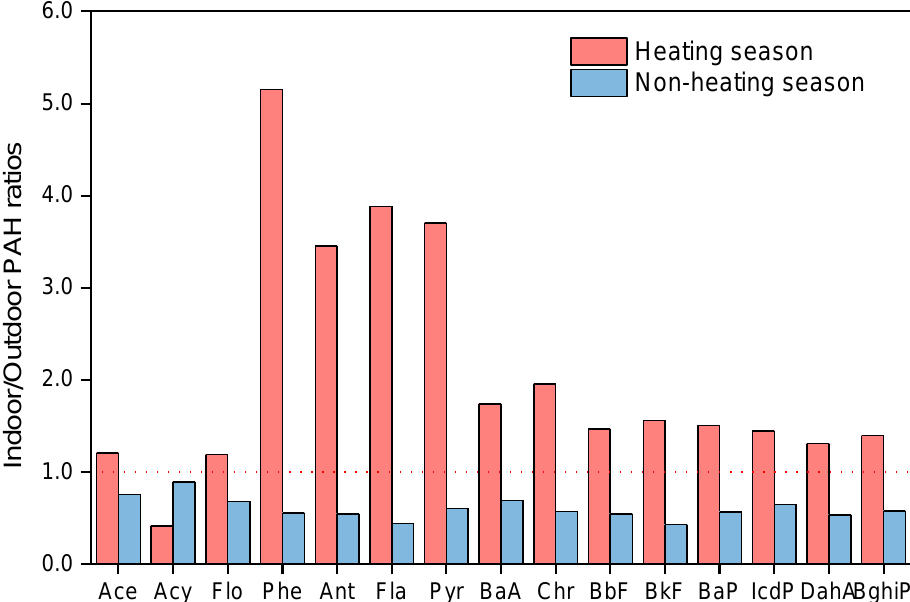
Figure 3. Indoor-to-outdoor polycyclic aromatic hydrocarbon ratios in the heating and non-heating seasons.